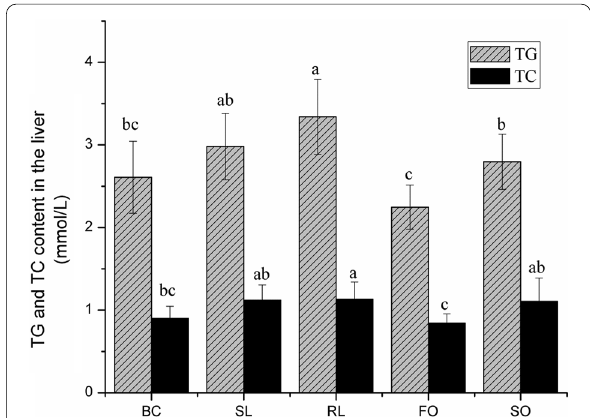
Fig. 2 Content of cholesterol and triglyceride in rat liver. Different superscript letters indicate that the contents of TC and TG in liver are significantly different at 0.05 significant level